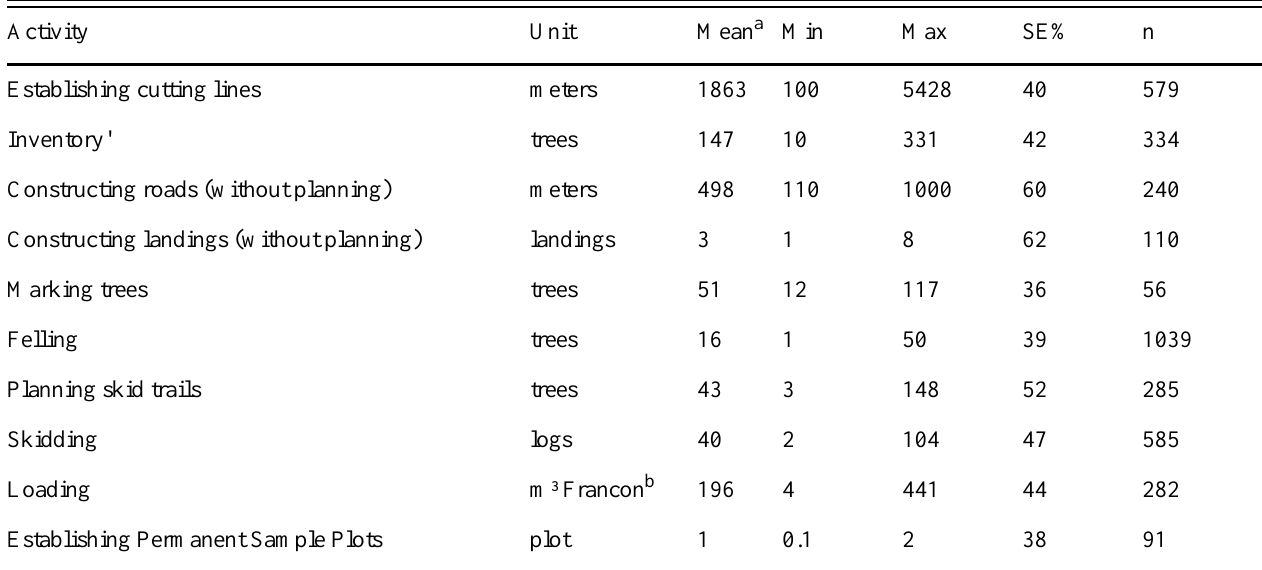
Table 4 . Average monthly production in the principal harvesting activities for the period August 2000 – December